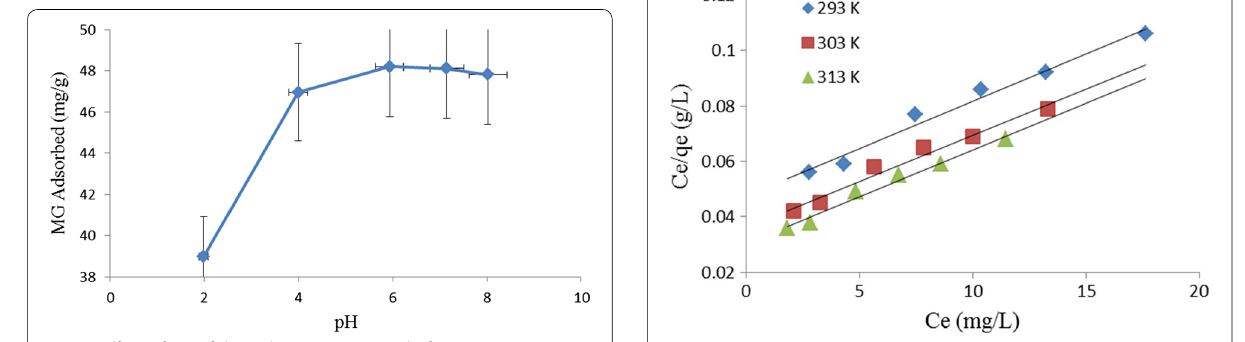
Fig. 3 Effect of pH of dye solution on removal of MG Fig. 4 Linearized Langmuir isotherm plot for removal of MG by